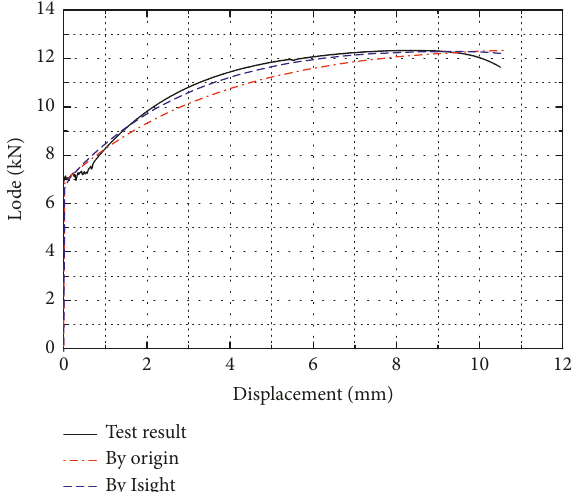
under different conditions.